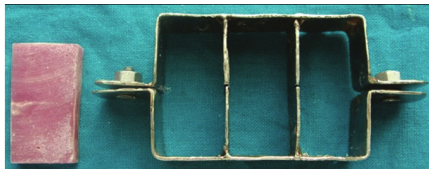
Figure 4: Metal housing in which acrylic block is fabricated (2 󸀠󸀠 × 4 󸀠󸀠 ).